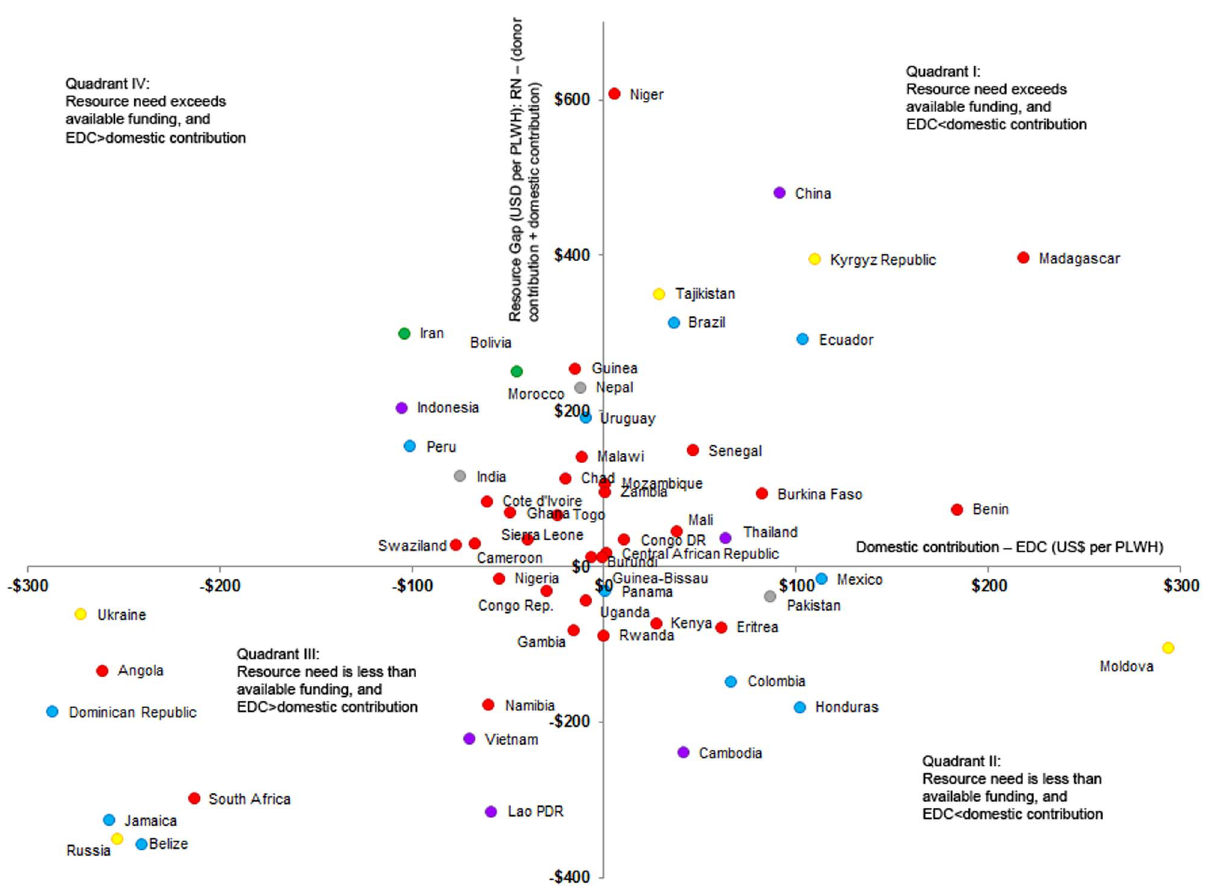
Figure 3. National HIV control resource availability and gaps, and the balance between domestic and donor funding contributions, in 2009. The x-axis is the national domestic contribution per person living with HIV (PLWH) in US $ minus the expected domestic contribution (EDC) per PLWH in US $ ; the y-axis is the HIV/AIDS resource gap: resource need minus international donor funding and minus actual domestic contribution, each per PLWH in US $ . The color of the circle refers to region: red for Africa, purple for East Asia/Pacific, gray for South Asia, green for Middle East, yellow for Europe and Central Asia, and light blue for the Americas. Outliers not shown on graph (but included in analyses and Table 1) are: in Quadrant I (Argentina, Azerbaijan, Bulgaria, Egypt, El Salvador, Paraguay, Philippines, Georgia, Belarus, Kazakhstan, Romania, Uzbekistan); Quadrant II (Botswana, Costa Rica, Chile, Nicaragua, Mongolia); Quadrant III (Fiji, Gabon, Malaysia); and Quadrant IV (Algeria, Armenia, Lebanon, Sri Lanka).